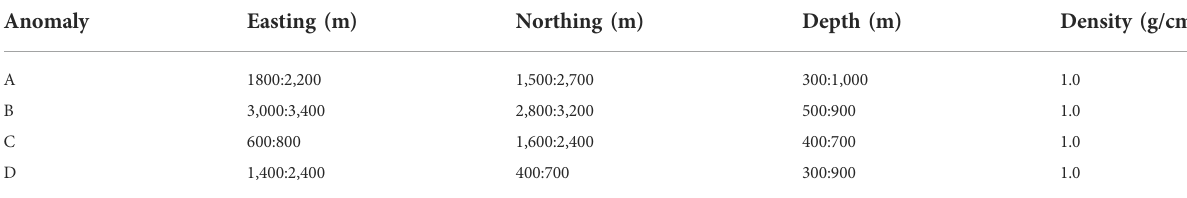
TABLE 3 Parameters of the sub-surface anomalous bodies.